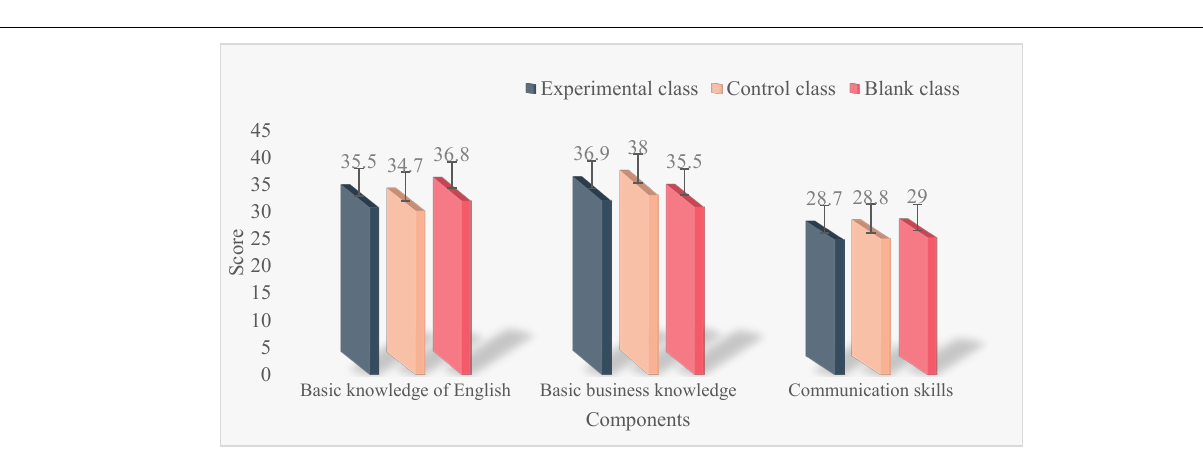
FIGURE 3 | Students’ evaluation of the effectiveness of teaching behavior.